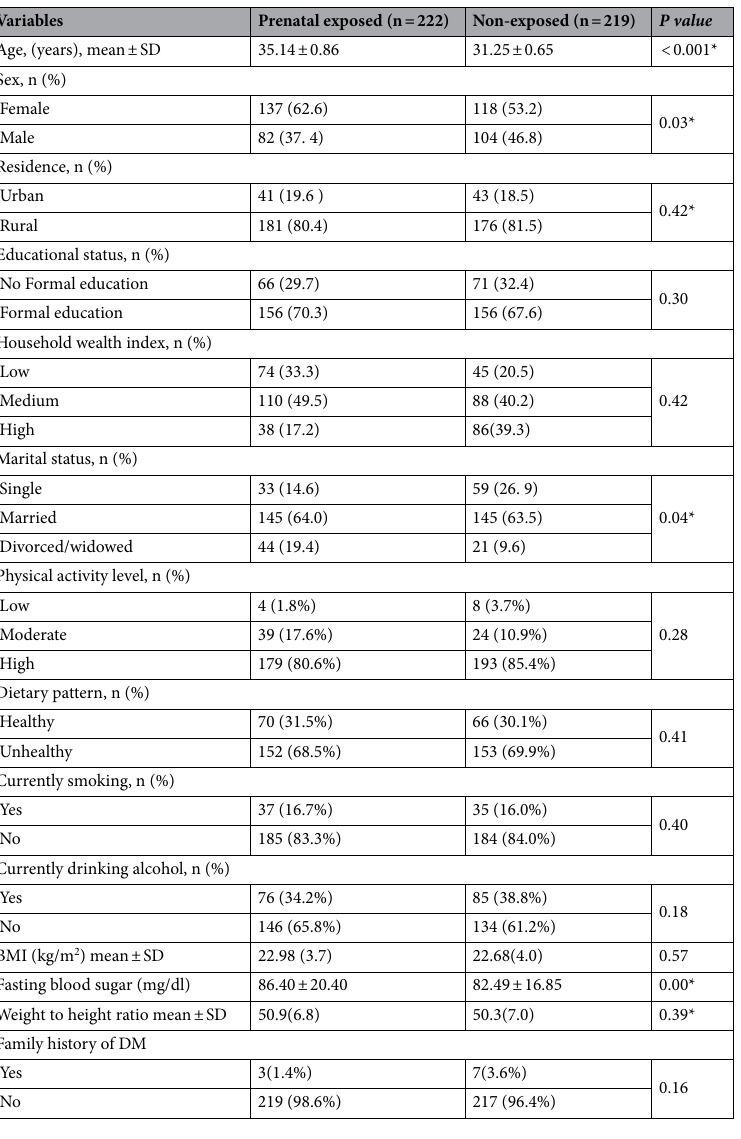
Table 1. Background characteristics of Ethiopian great famine exposed and non-exposed groups in North Wollo Zone, Raya Kobo district, Northeast Ethiopia, 2019. P value—represents Independent Samples t-tests for continuous variables or χ 2-test for categorical variables, *Statistical significance.